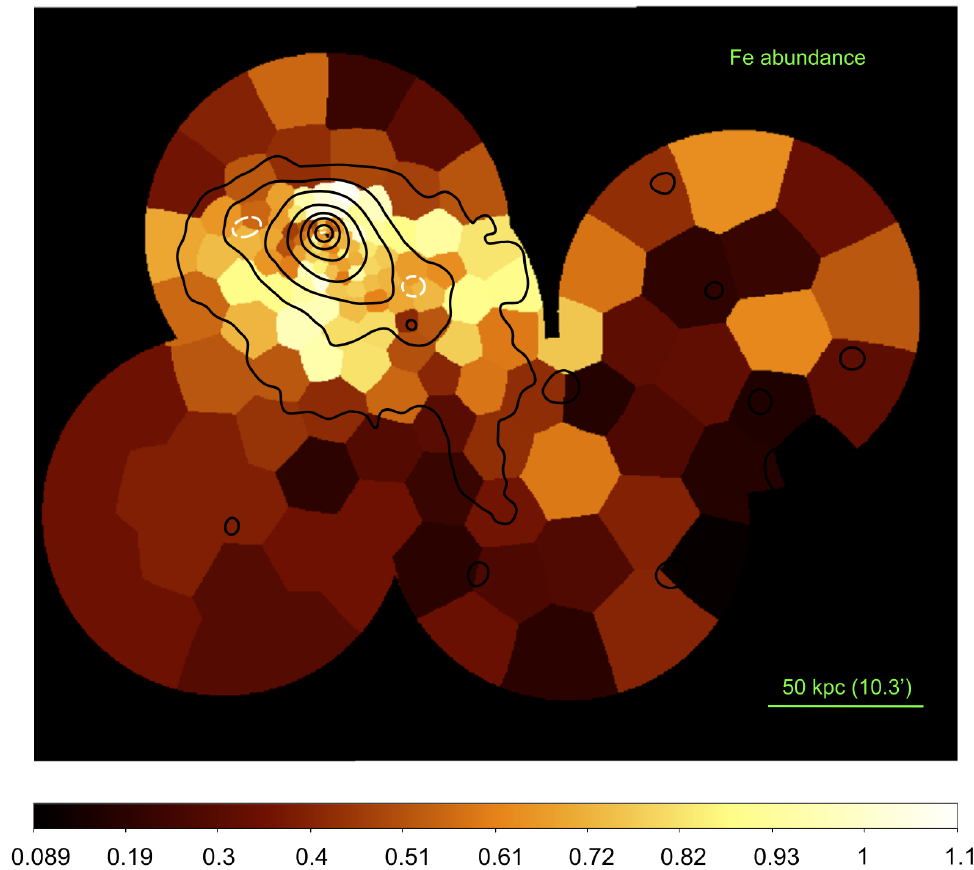
Figure 6. XMM- Newton spectroscopic map of the Fe abundance in M49 in units of the Solar abundance of Reference [43], derived assuming a single temperature model. X-ray contours in the 0.7–1.3 keV energy band are overlaid in black. The Fe distribution is elongated in the direction of the AGN ghost cavities (denoted by white dashed circles), with an additional extension towards the west/southwest on larger scales, likely related to a ram-pressure or slingshot tail as the galaxy is falling into the Virgo Cluster. Figure reproduced with permission from Reference